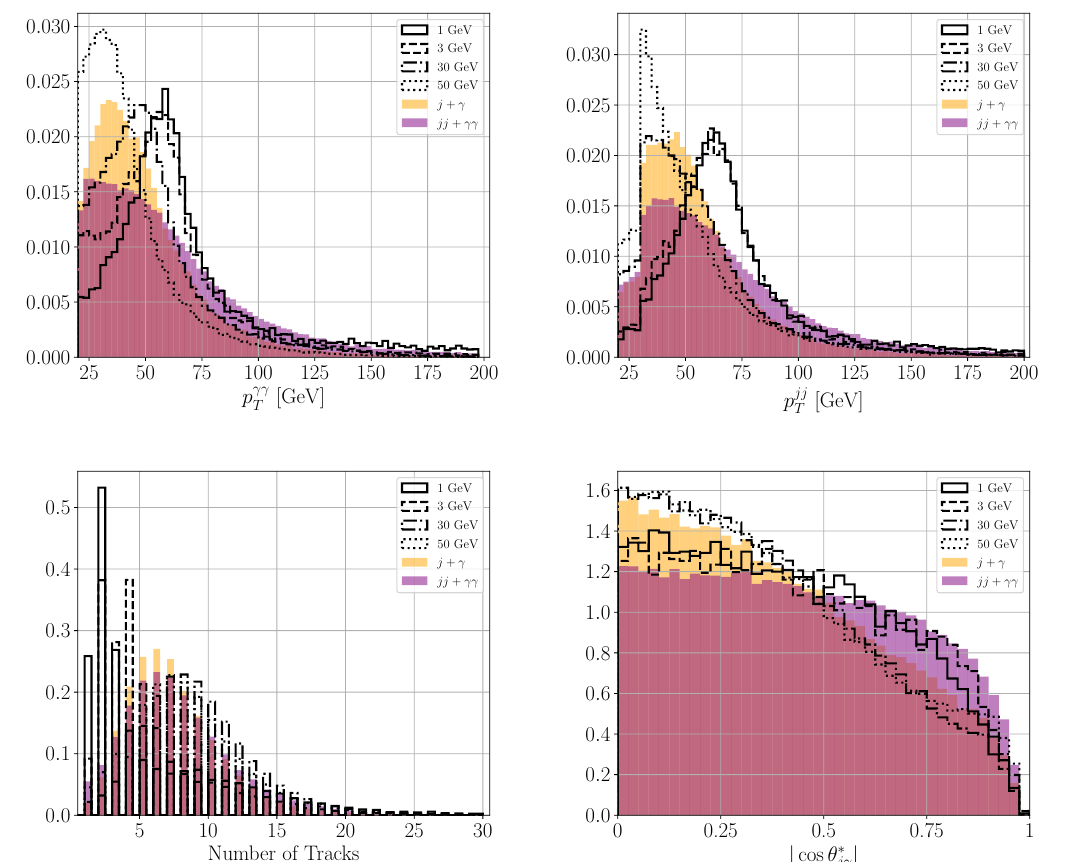
(lower right). We display the jγ